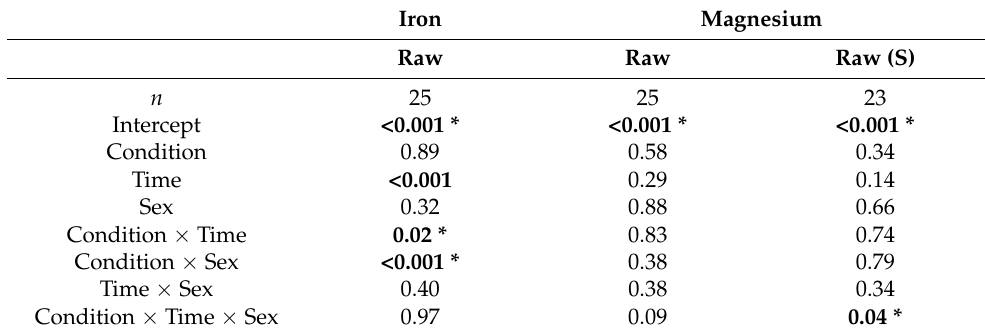
Table A1. p -values from mixed models using raw concentrations, uncorrected for baseline values. Iron Magnesium